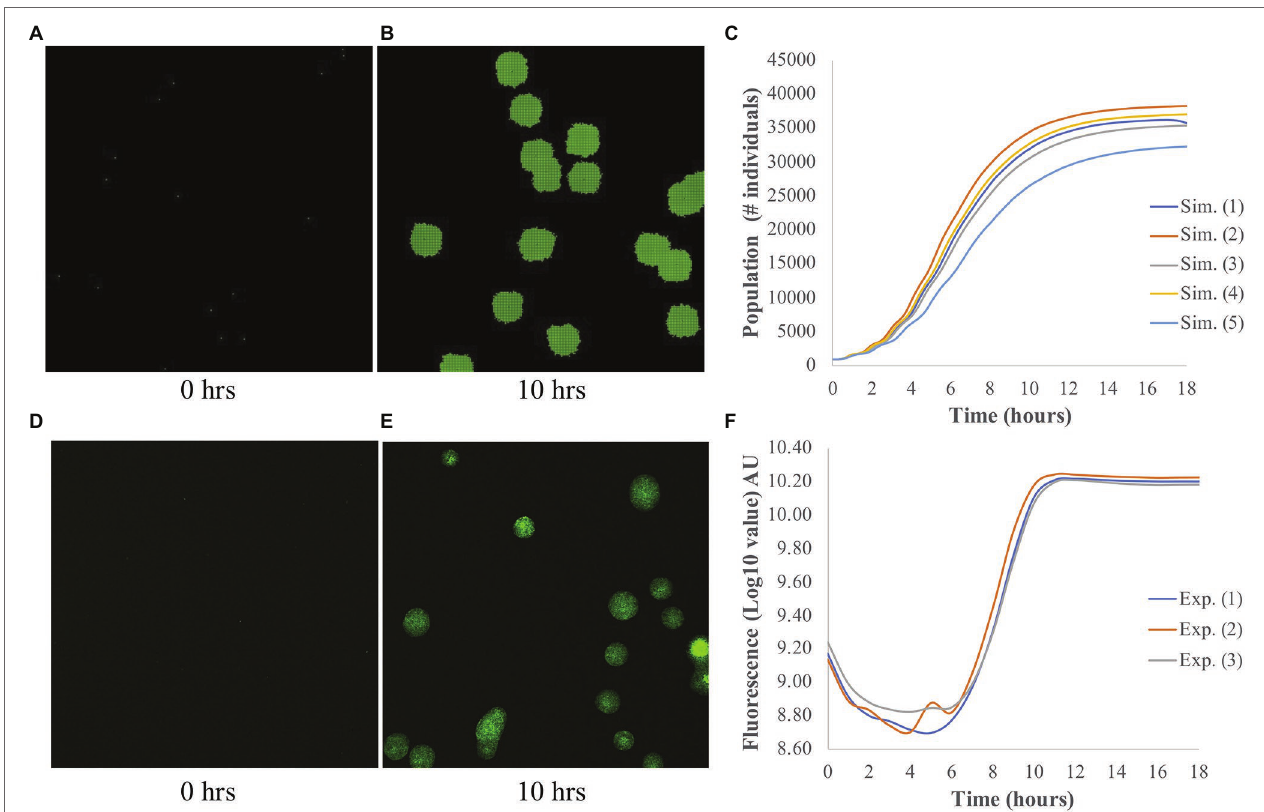
FIGURE 1 | Simulated and experimental population growth of Pantoea . (A–C) Simulated growth. Snapshots of simulated microbial population at (A) t = 0 h and (B) t = 10 h. (C) The corresponding population curve, which shows the typical logistic shape. (D–F) Experimental growth. Representative images of bacterial colony growth at (D) t = 0 h and (E) t = 10 h. Images were taken from individual wells for measurements of fluorescence intensity. (F) The corresponding population curve shows the changes in fluorescence intensity over time. Fluorescence is measured from Pantoea sp. YR343 expressing GFP and is used to measure the growth of these cells over time. Note the different y -axes of (C) and (F)